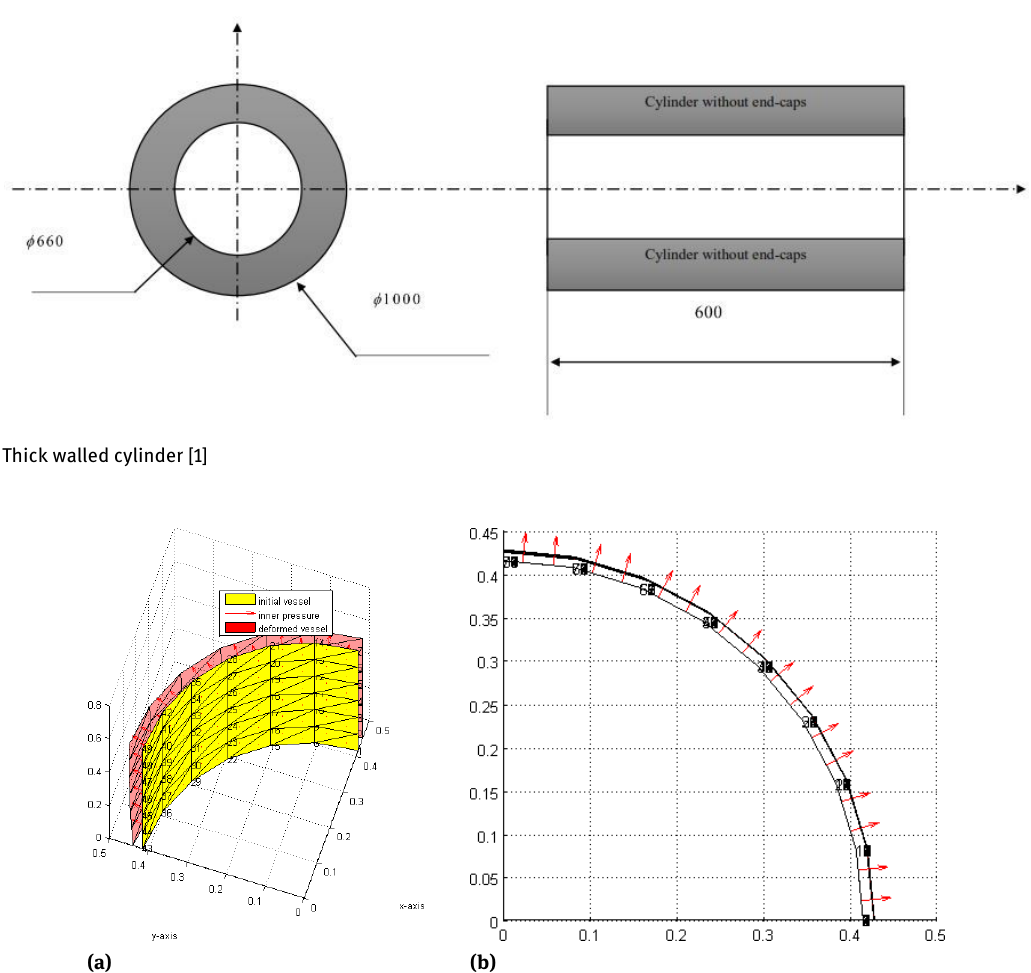
Figure 14: Iinitial and deformed configuration of ¼ mid surface of the vessel